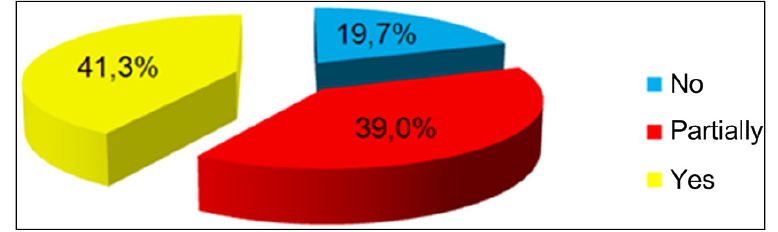
Figure 1. The values of all answers from the questionnaire relating to project maturity in Serbian energy sector,